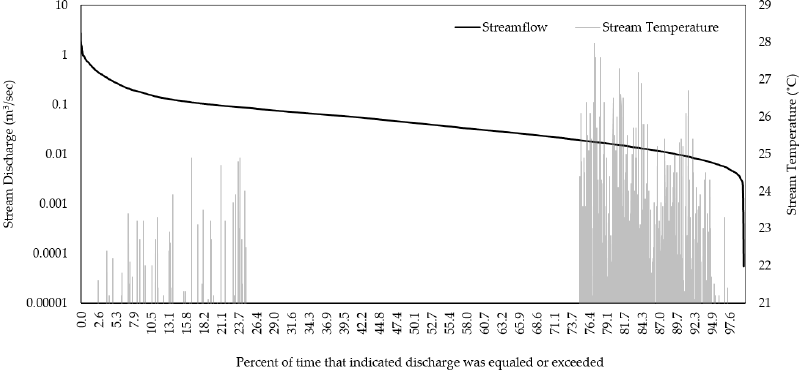
Figure 7. Cork Brook simulated historical flow duration curve and stream temperatures. The secondary y-axis begins at 21 °C and any temperatures that are not above the stressful threshold are not shown in the figure. The stream temperatures in the Q25–Q75 range are omitted from the figure.